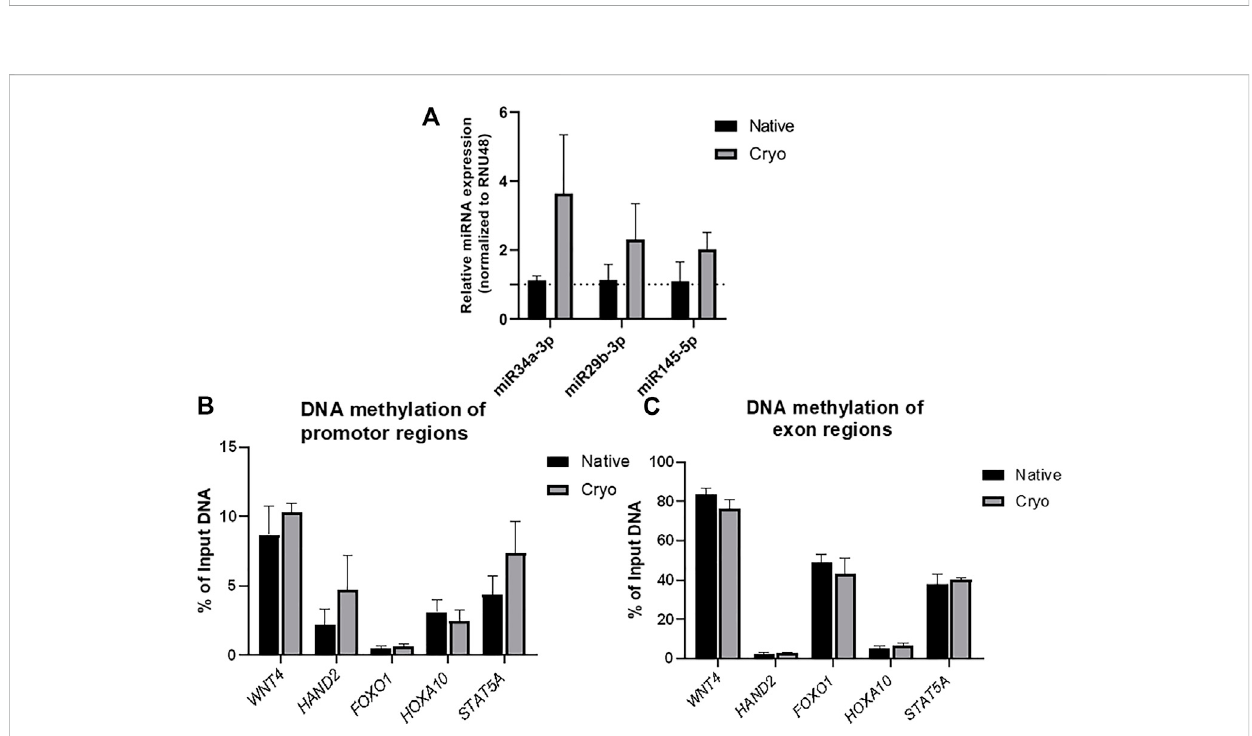
Epigenetic factoranalysis ofnative and cryo hPMSCs. (A) miRNA expressionevaluation ofnativeand cryo hPMSCs byRT-qPCR. RNU48 was used as an internal control for miRNA level normalization. Results were calculated using the ΔΔ Ct method and represent changes from native cells. Results are shown as mean ± S.D. ( n = 3). The levels of DNA methylation at speci fi c gene ( WNT4 , HAND2 , FOXO1 , HOXA10 , and STAT5A ) promoters (B) and exon (C) regions were evaluated by performing methylated DNA immunoprecipitation (MeDIP) following qPCR analysis. IgG represents negative MeDIP test control. Results are shown as mean ± S.D. ( ? = 3) and represent the percentage of immunoprecipitated DNA amount to total DNA